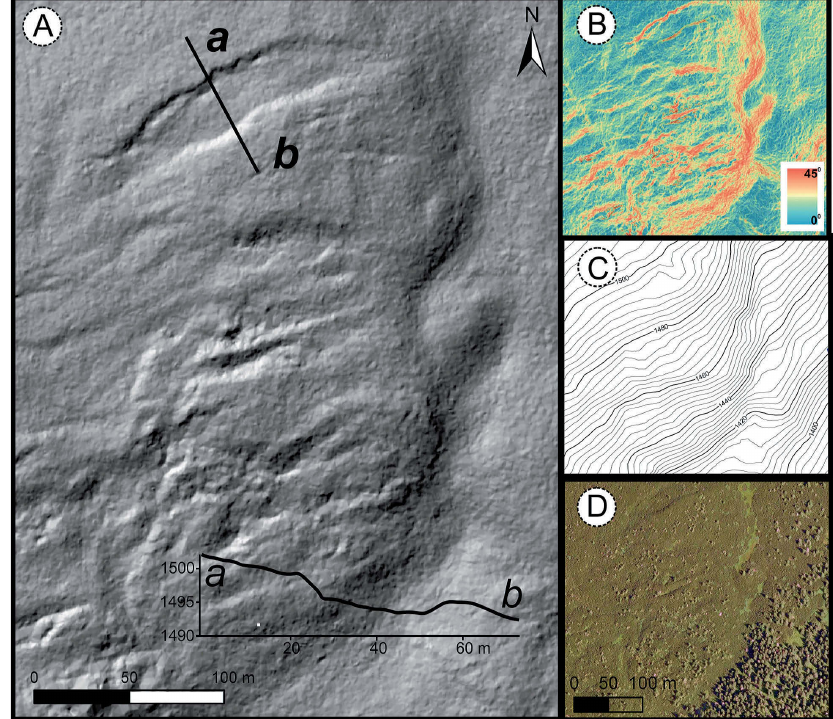
Fig. 5. Test area No 4. A – LiDAR image (a–b – topographic profile and its location), B – the map of slope reductions generat- ed from LiDAR (range of slope reductions is given), C – contour-line map, D – orthophotomap. Maps B–D at the same scale, Map A at larger